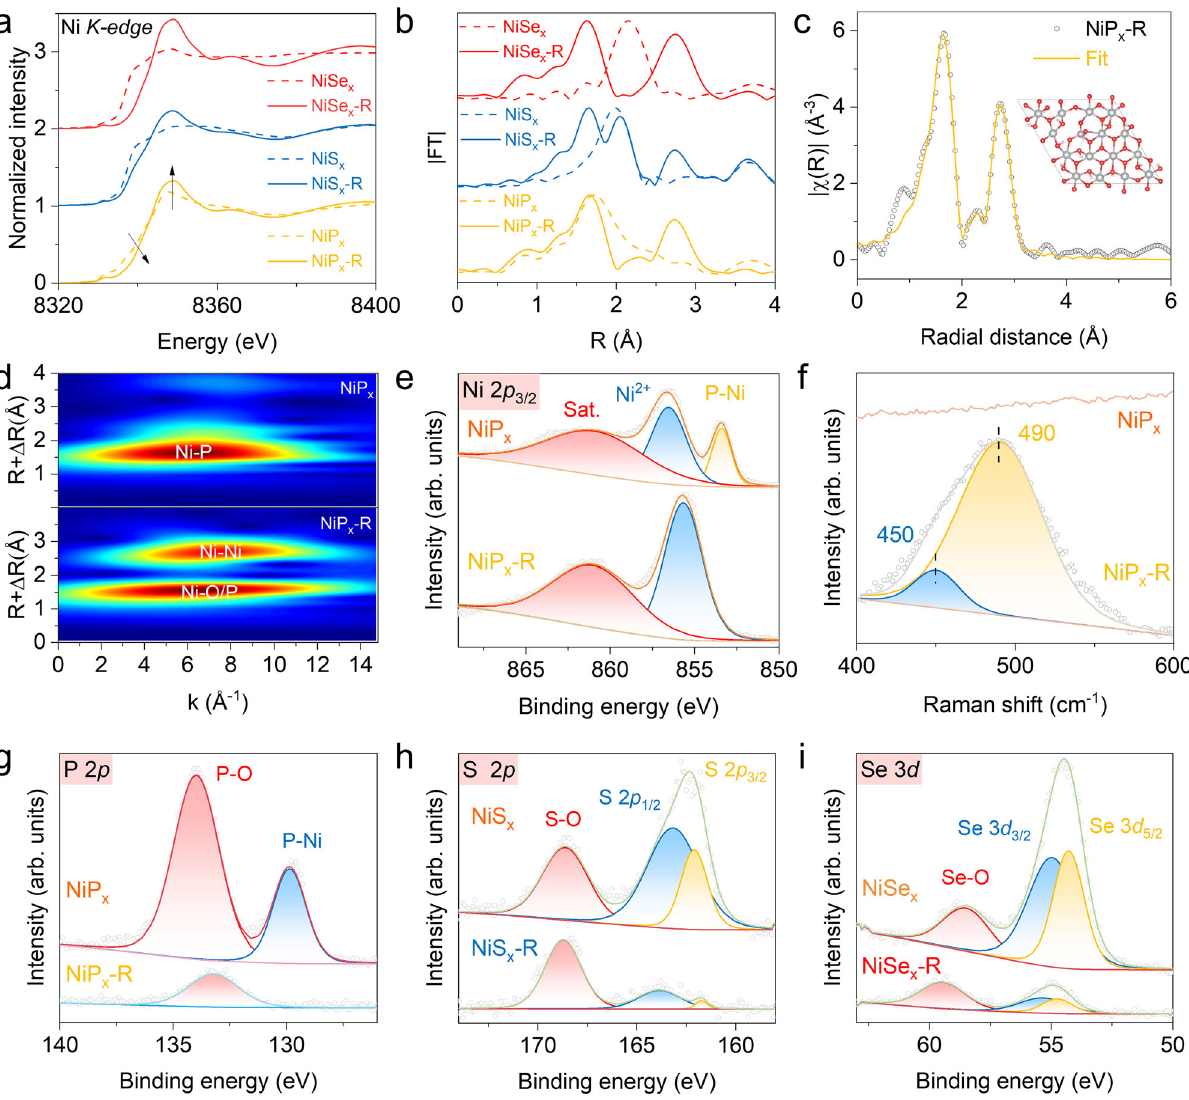
Fig. 3 Electronic structures and chemical environments of NiT x and NiT x -R. a XANES and b FT-EXAFS of Ni K-edge spectra for NiT x and NiT x -R. c EXAFS fi tting results of Ni K-edge at k-space of NiP p XPS spectra, f Raman spectra, and x -R. d WT-EXAFS at Ni K-edge for NiP x and NiP x -R. e High-resolution Ni 2 g high-resolution P 2 p XPS spectra of NiP x and NiP x -R. h High-resolution S 2 p for NiS x and NiS x -R. i High-resolution Se 3 d for NiSe x and NiSe x